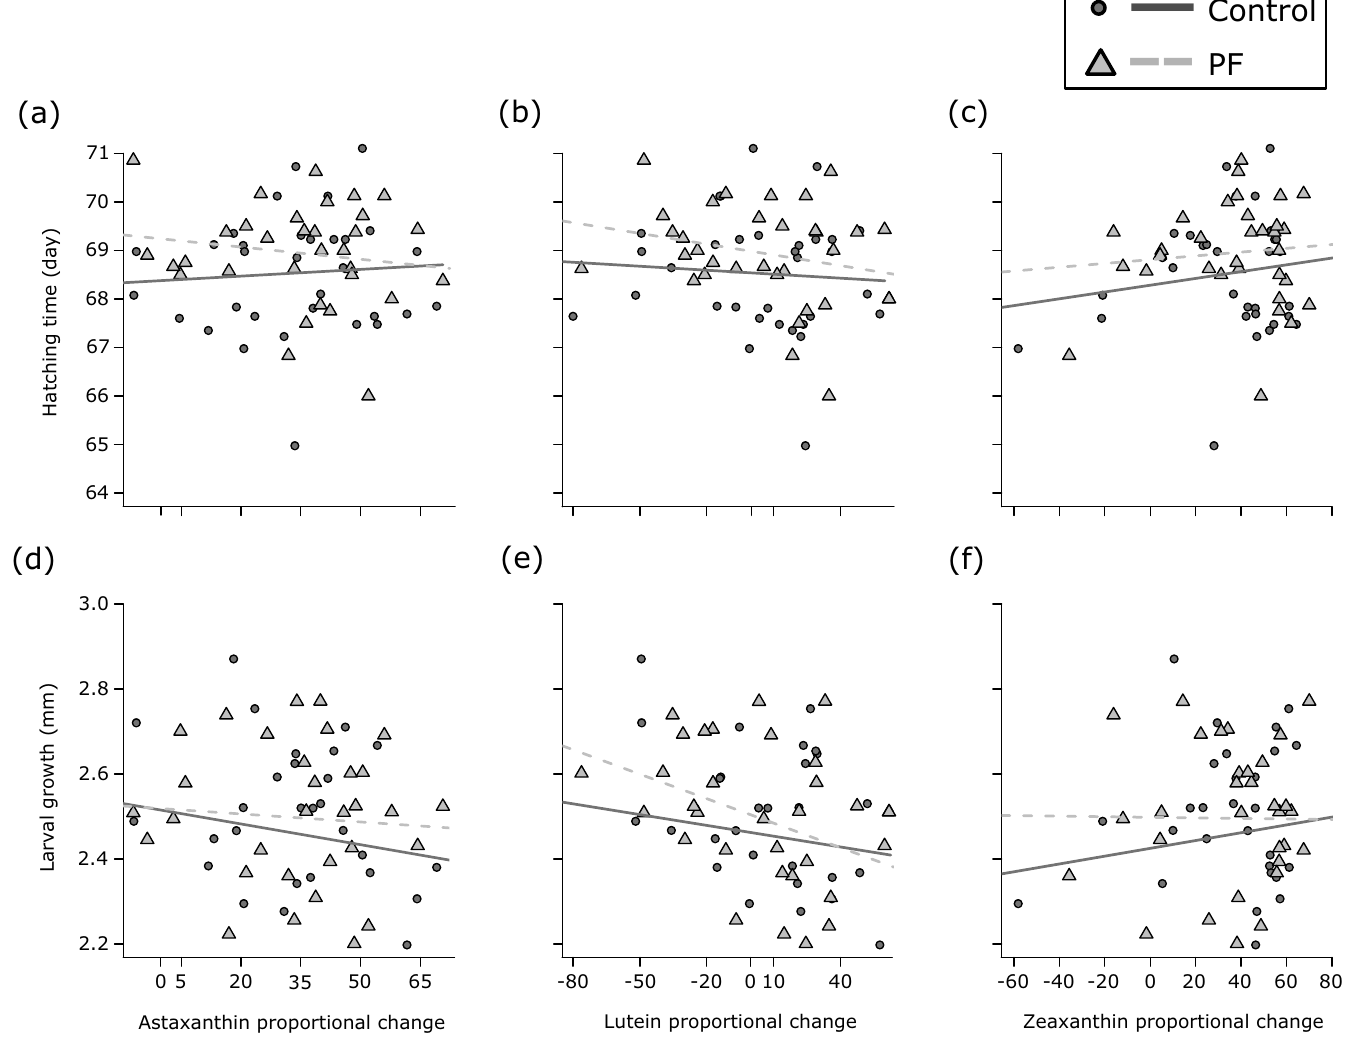
Fig 3. Proportional changes in carotenoid content relative to early fitness-related traits. Embryo hatching time (a–c) and larval growth (d–f) are shown for change in astaxanthin, lutein, and zeaxanthin. Changes in carotenoid contents are given for sham-treated controls (circles and solid lines) and PF treated samples (triangles and dashed lines). See Table 3 for